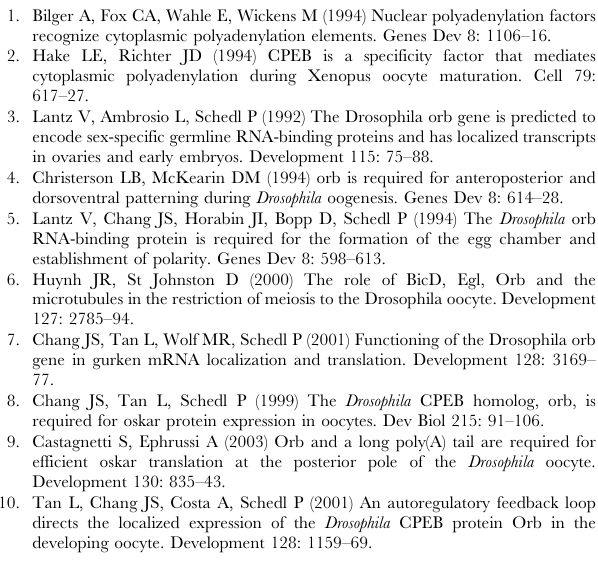
Figure S2 Poly(A) tails are elongated in cup 1355 . Poly(A) tails of orb mRNA from wild type and cup 1355 (as indicated) were analyzed using the anchored poly(A)-tail assay [24]. Anchor primers for reverse transcription and amplification from the poly(A) tail were as described in [24], while the nested orb specific primers (F2 and F4) were derived from the orb 3 9 UTR. The amplification products were analyzed on an agarose gel and visualized with ethidium bromide. (PDF) Table S1 cup negatively regulates orb and suppresses the ventralization phenotype of HD19Gorb 343 . Females that were trans-heterozygous for HD19Gorb 343 and five different alleles of cup mutants were generated by crossing HD19G orb 343 / TM3Ser females (n= 10 in each cross) with cup/CyO males. Independent crosses were set up and scored at 18 u C and 25 u C. The number of embryos scored at each temperature is shown in the table. While approximately 20–30% of embryos laid by HD19G orb 343 / + females were ventralized, suppression of this phenotype was seen in trans-heterozygotes of all five alleles. Approximately 2.5–7.3% of embryos laid by cup mutant transheterozygotes were ventralized at 18 u C. Suppression was weaker but still very obvious and statistically significant at 25 u C, where 8.6–20.4% of embryos were